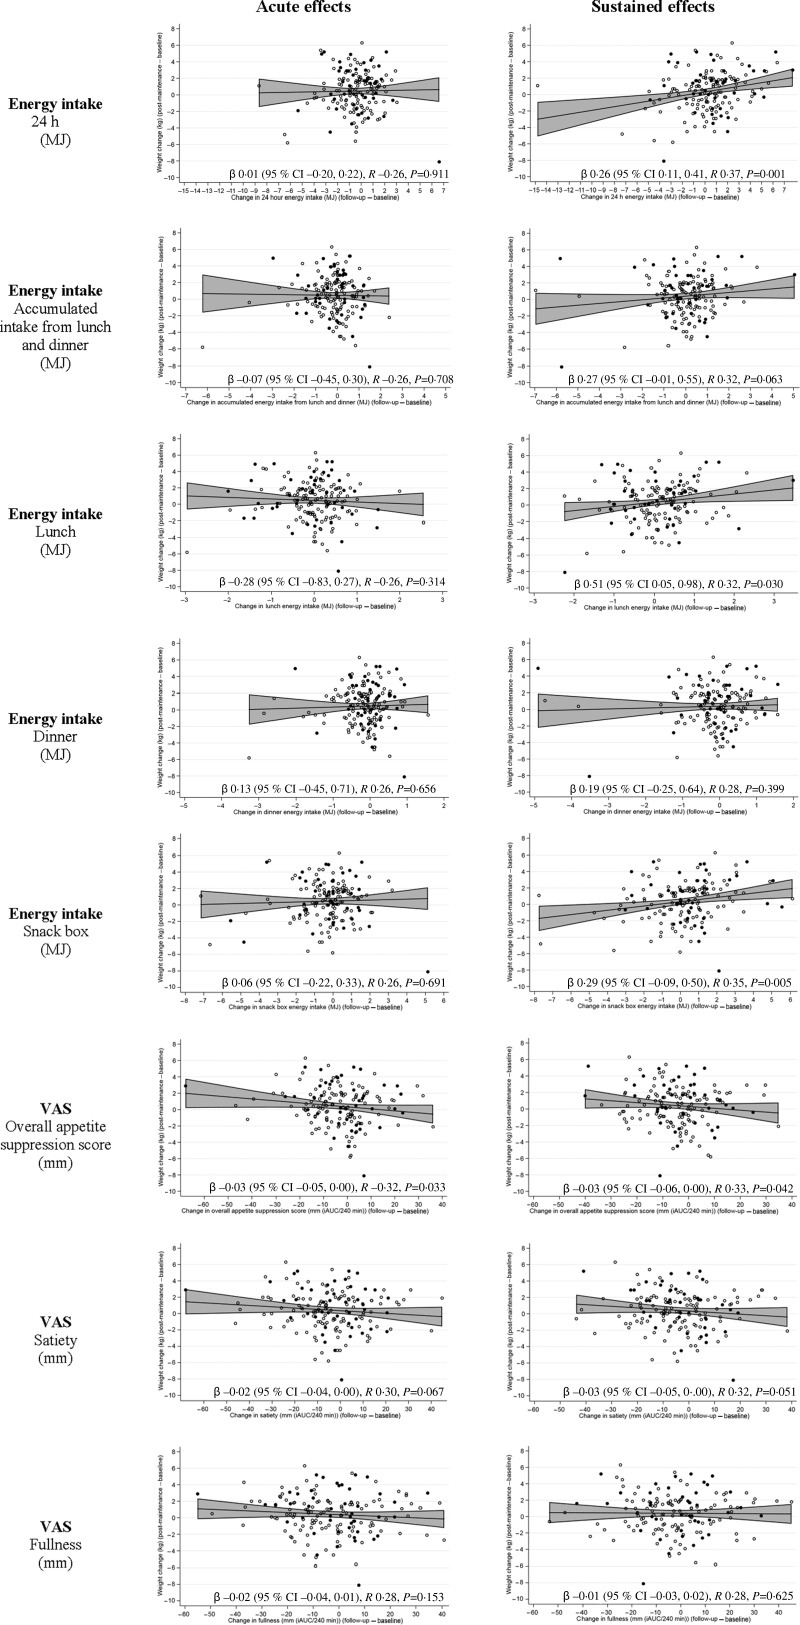
Relationship between changes in appetite (24-h energy intake, energy intake at each of the ad libitum meals and summarised incremental AUC (iAUC) of each of the self-reported appetite evaluations divided by acute (after a single exposure) and sustained (after repeated exposures) effects) and changes in body weight (kg) from pre- to post-maintenance. VAS, visual analogue scale; acute effects, difference in measures of appetite between the first and the second appetite probe days; sustained effects, difference in measures of appetite between the first and the third appetite probe days; overall appetite suppression score = (satiety + fullness + (100 – hunger) + (100 – desire to eat) + (100 – prospective food consumption))/5; 0 indicates higher appetite/less satiety and 100 indicates lower appetite/more satiety. Positive change in energy intake equals increased energy intake/higher appetite. Positive change in self-reported appetite evaluation equals decreased appetite. Positive weight change equals weight regain after the weight loss maintenance period. Data are presented as unstandardised regression coefficients (β) and 95 % confidence intervals and correlation coefficients using linear mixed models including adjustment for age, sex, pre-maintenance body weight, body weight change during the low-energy diet period and baseline measure of appetite of interest (e.g. when examining association between changes in 24-h energy intake and changes in body weight, the model was adjusted for 24-h energy intake at baseline) (fixed effects) as well as site (random effect). ●, Men (n 47); ○, women (n 134); ––, fitted line; , 95% CI.